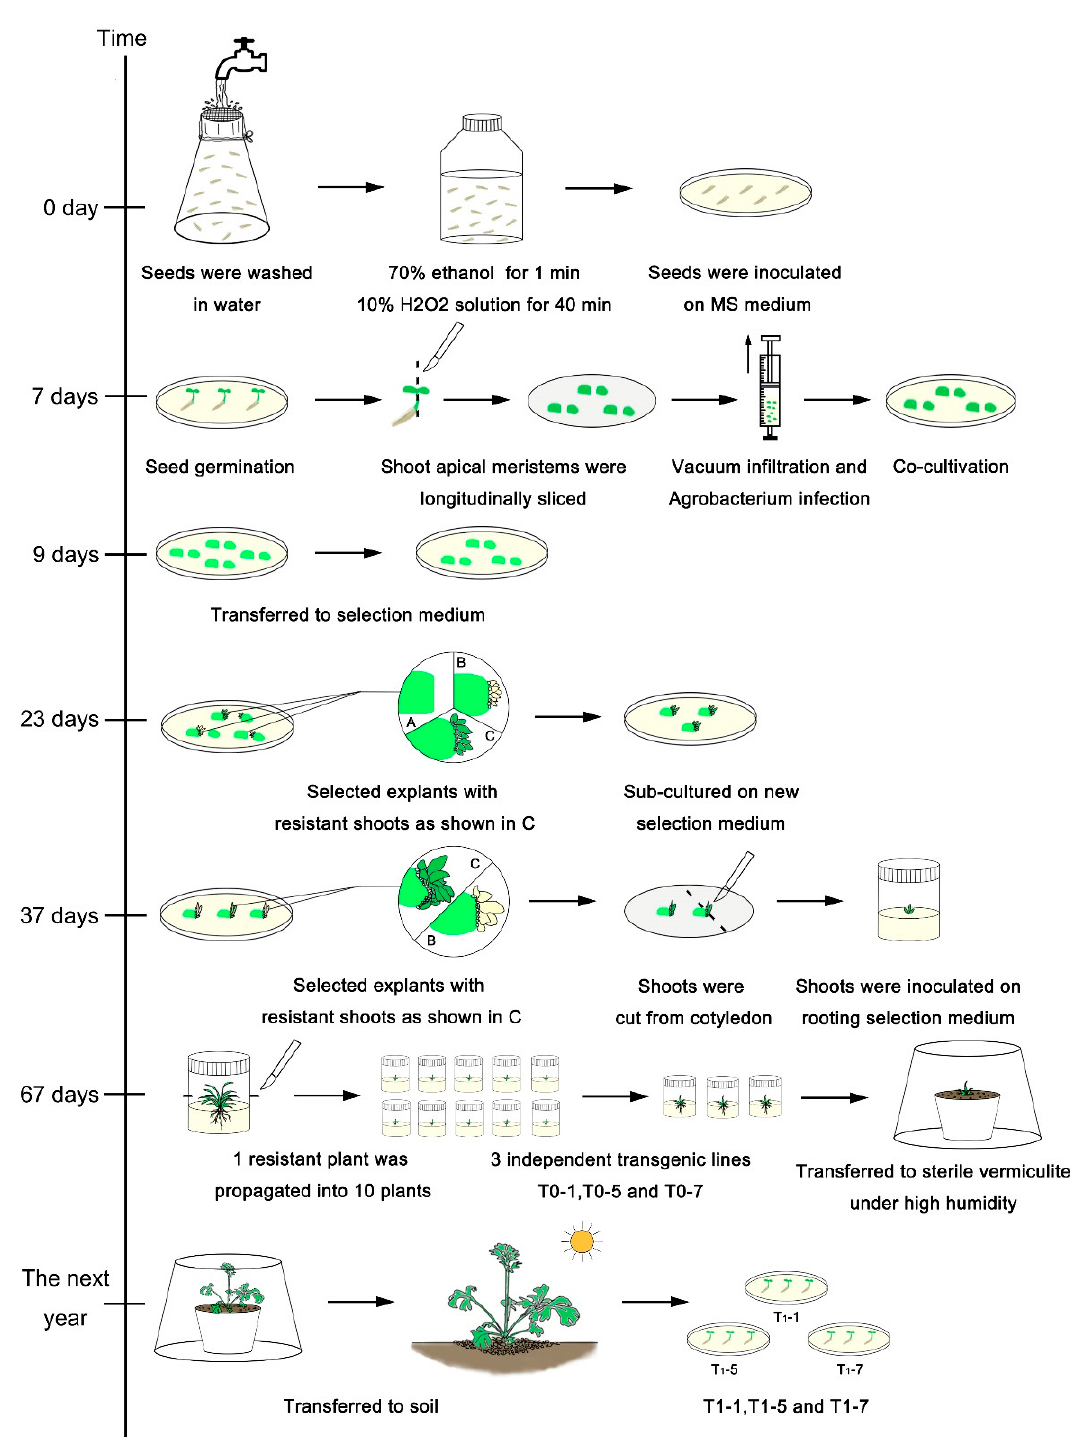
Figure 5. Workflow of pyrethrum transformation using shoot apical meristems of germinated seedlings. A: No regeneration. B: Blbino buds. C: Kanamycin-resistant buds. Seeds from transgenic proTcCHS-GUS plants (T0-1, T0-5, and T0-7) were germinated aseptically and separately on MS medium. After 2 weeks, seeds were subcultured on MS medium supplemented with 30 mg L − 1 kanamycin to screen transgenic progeny